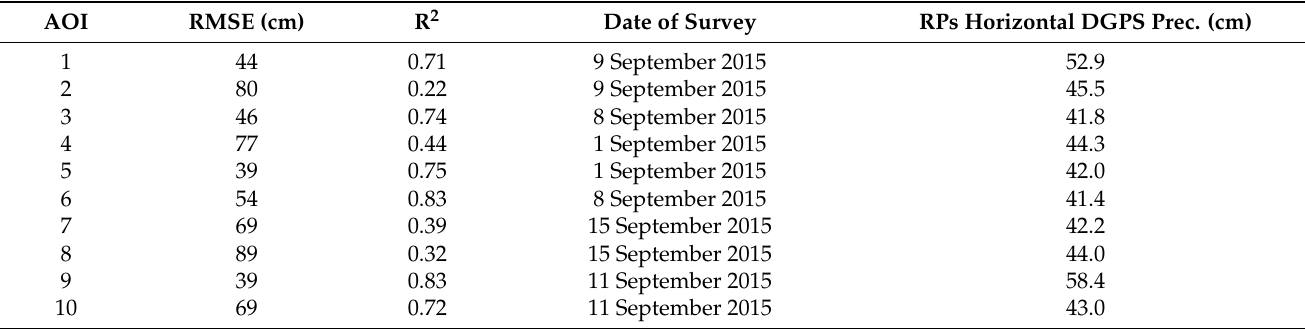
Table 1. RMSE of reed stem heights at the different